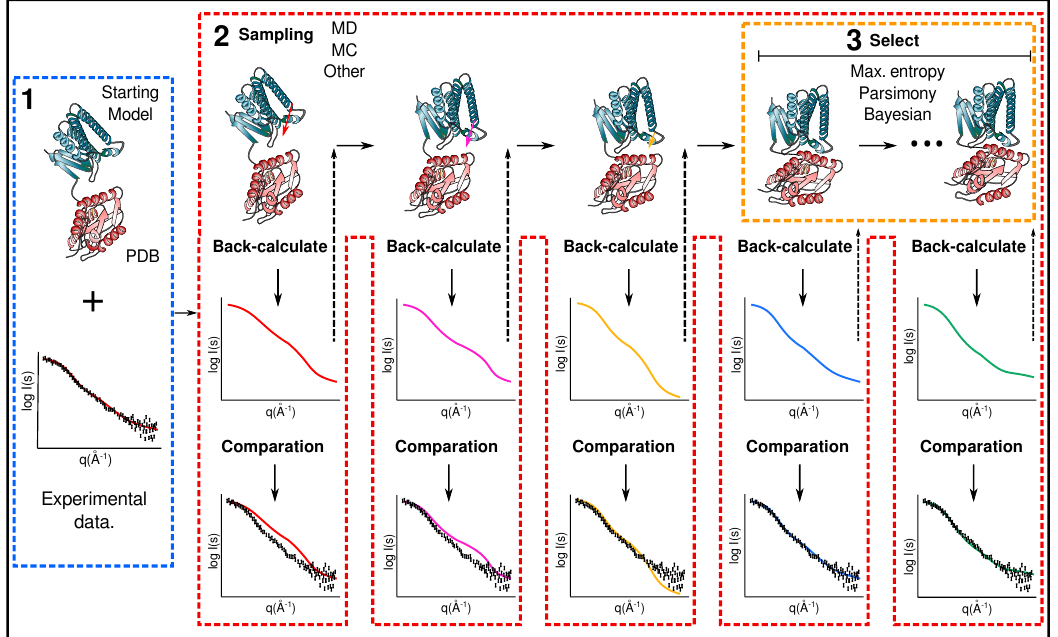
Figure 1. Schematic representation of the di ff erent steps in the guided simulation approach. (1) First, the experimental data are acquired and a structural model of the protein is selected. (2) Then, the experimental data are used as a restraint in the computational sampling protocol. This approach involves evaluating (back-calculated and comparing) each model during the simulation. As a result of this, the sampling space is reduced, and only conformations that correlate with the experimental data are sampled. (3) Finally, the conformers that best describe the data are